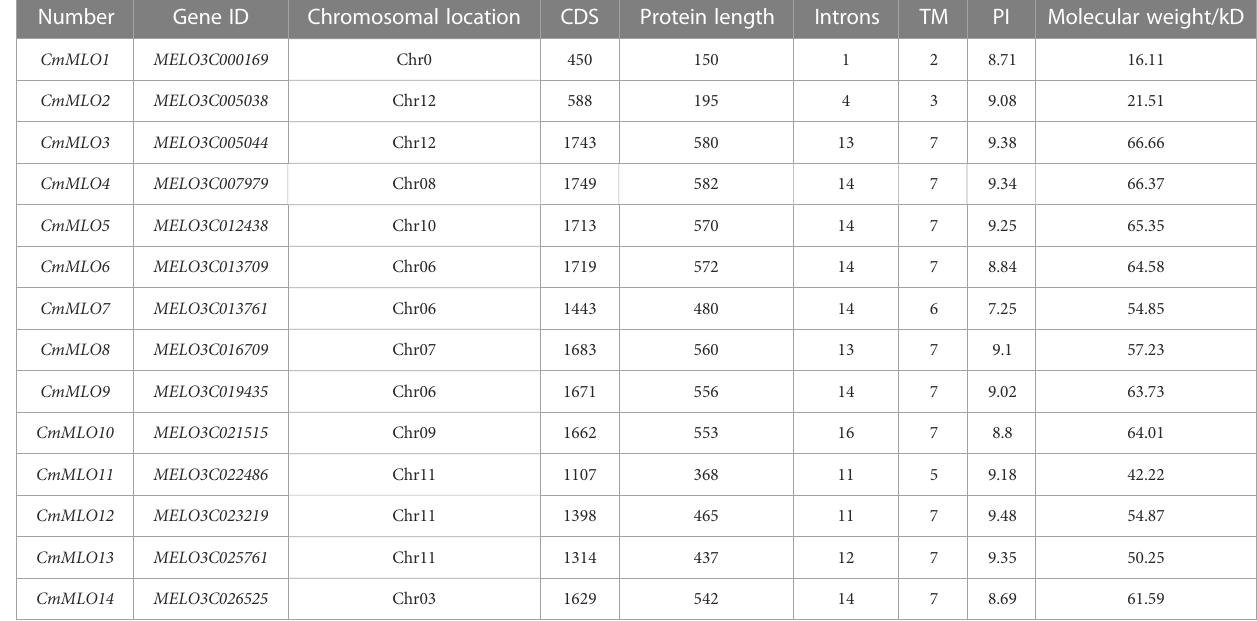
TABLE 2 Identi fi cation of fourteen MLO genes in melon genome.